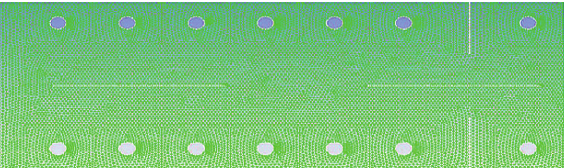
Figure 6: The longitudinal section model meshed in